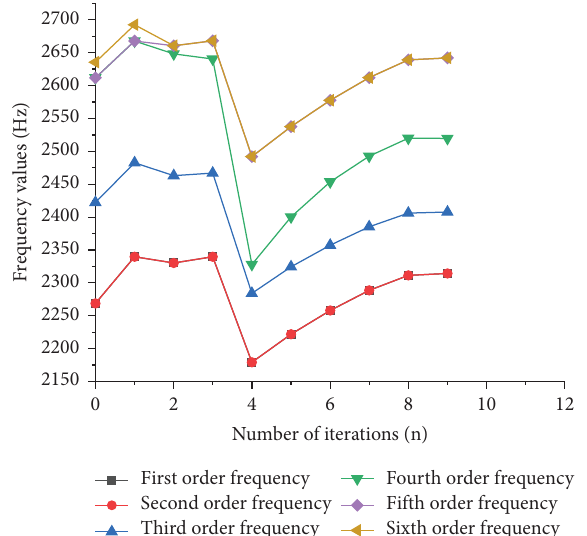
Figure 12: Schematic of the frst six-order frequency iteration process of multiobjective